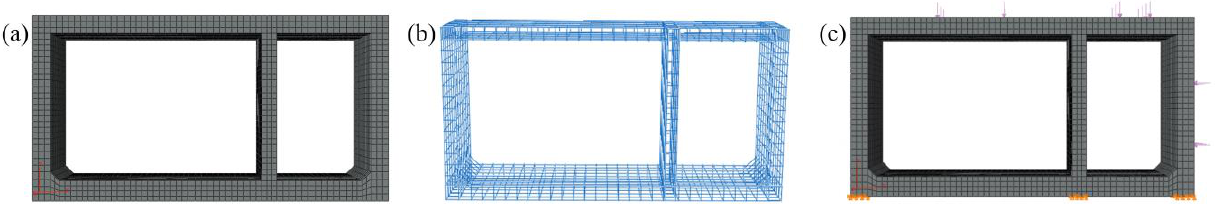
Figure 14. Finite element analysis models of cast-in-place underground utility tunnel: ( a ) concrete model; ( b ) reinforcement model; and ( c ) utility tunnel model.